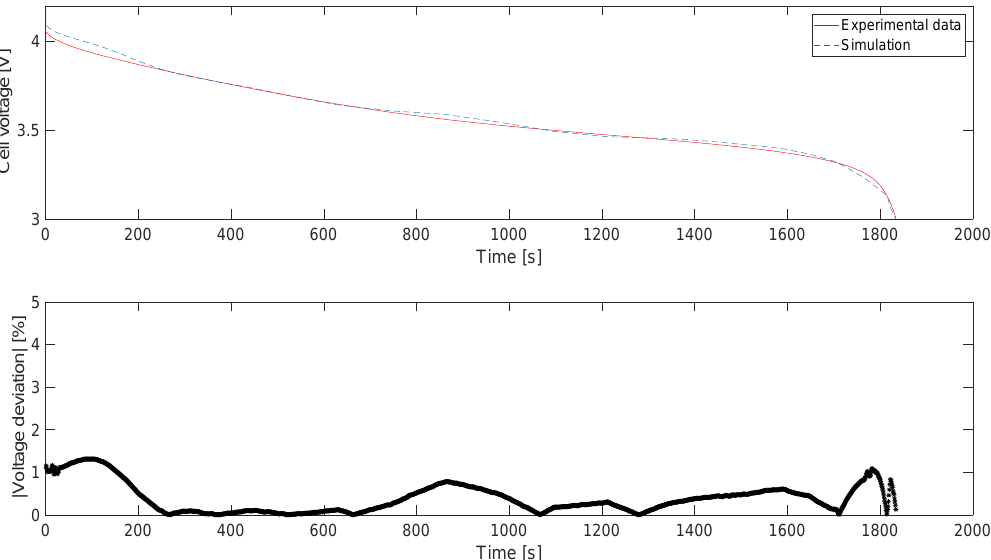
Figure 17. ( Upper ) Uncycled cell voltage during high constant current discharge at 35 ◦ C cycling temperature; ( Lower ) Absolute value of the voltage deviation between experimental and simulations